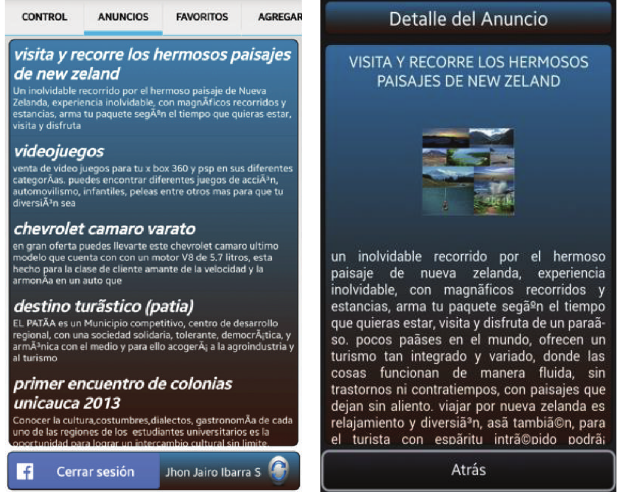
Figure 8: Mobile device adds list